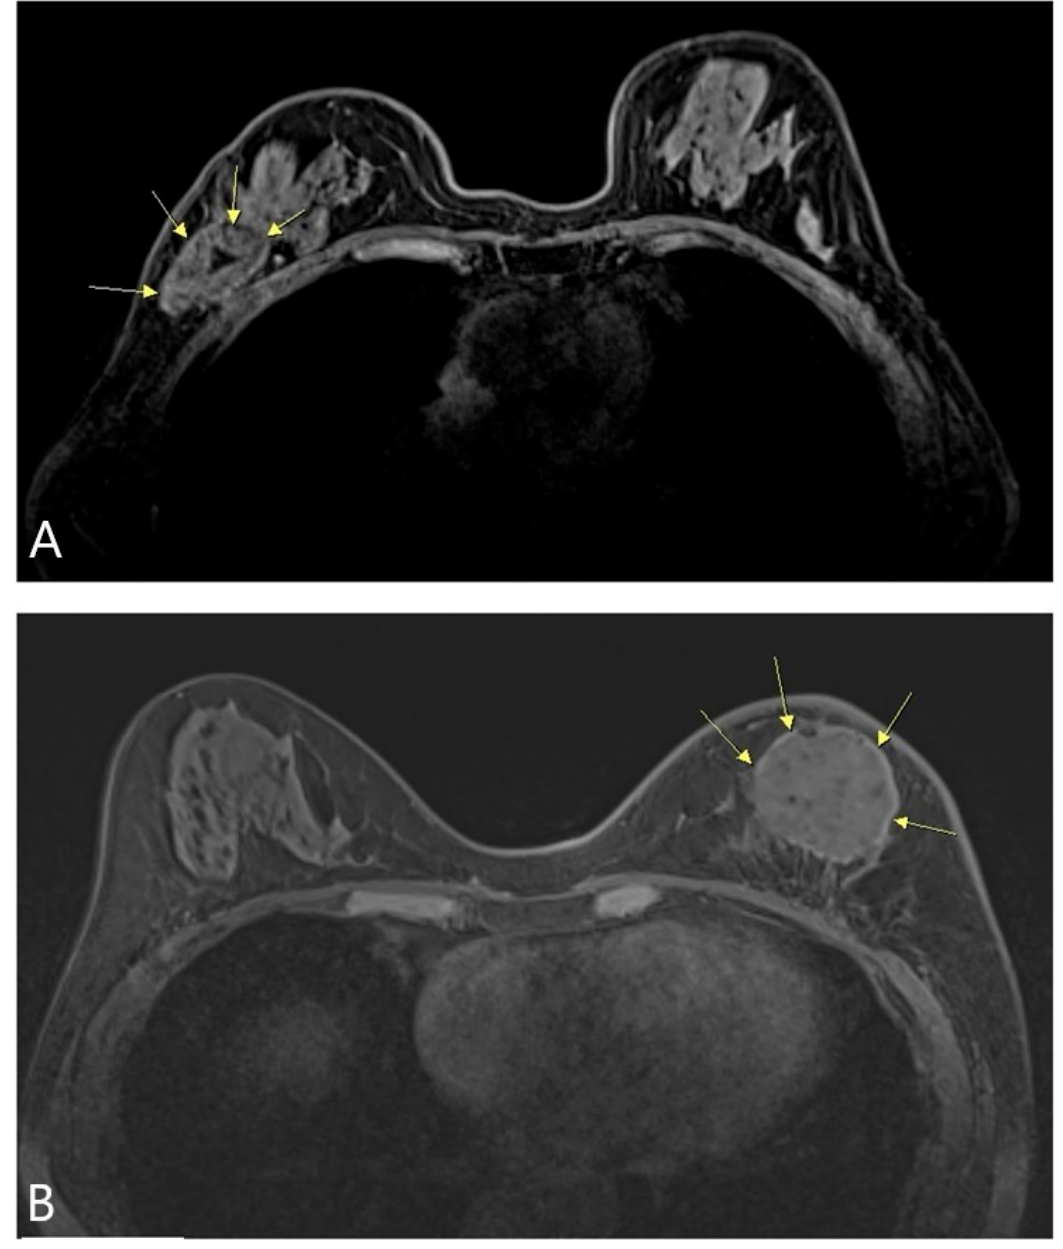
Figure 5. MRI on the breasts was performed after reconstruction using two types of ADM. ( A ) The sheet-type ADM (yellow arrows) was used in this BCS patient. ( B ) The pellet-type ADM (yellow arrows) was applied for reconstruction after BCS. ADM, acellular dermal matrix; BCS, breast-conserving surgery; MRI, magnetic resonance imaging.